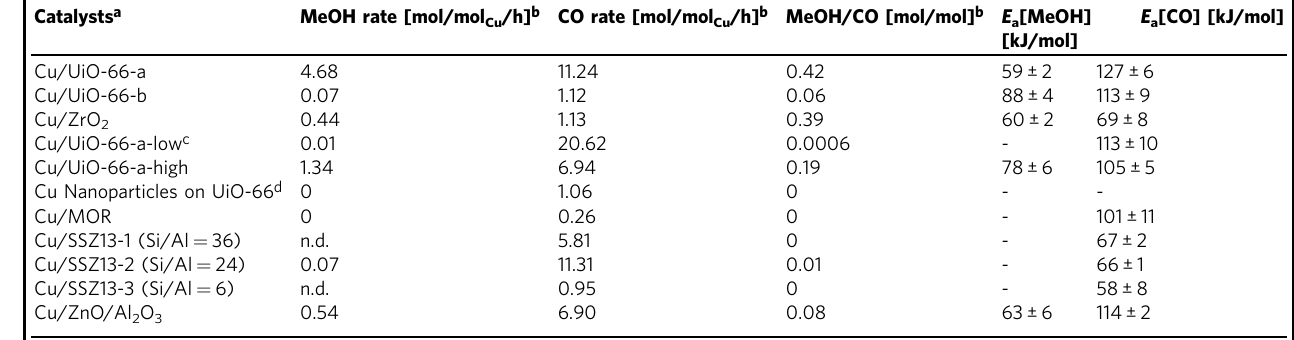
Fig. 4 Catalytic performance of selected materials. a Rates of methanol (MeOH) production (orange bars), methanol selectivity (green bars) on selected catalysts at 250 °C and 32 bar, and activation energy ( E a , pink points). b Arrhenius plots for methanol production on selected catalysts. The colors of the lines match the colors of the names of the materials. c Methanol and CO production on Cu/UiO-66-a. d Rate of methanol production on Cu/UiO-66-a as a function of time on stream for reaction conditions of 250 °C, 32 bar and CO 2 /H 2 /N 2 = 7/21/1 mL/min. e The methanol and CO selectivity as functions of CO 2 conversion for Cu/UiO-66-a at 190 °C and 32 bar. The CO 2 conversion is varied by changing the gas space velocity. Table 2 Catalytic performance of selected tested